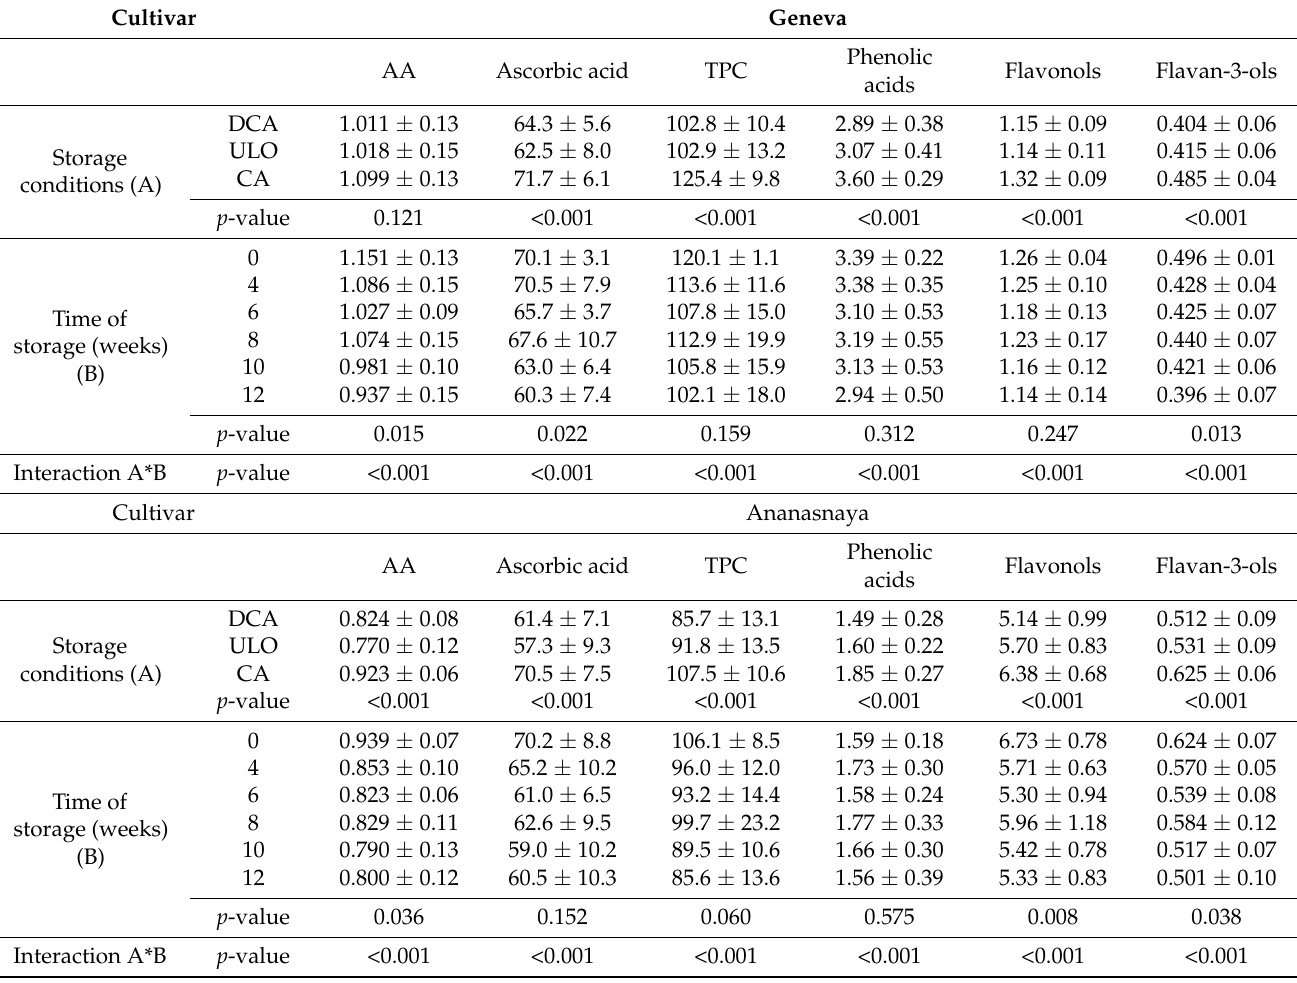
Table 3. Changes in antioxidant activity (mg AAE · 100 g − 1 F.W.) and ascorbic acid and